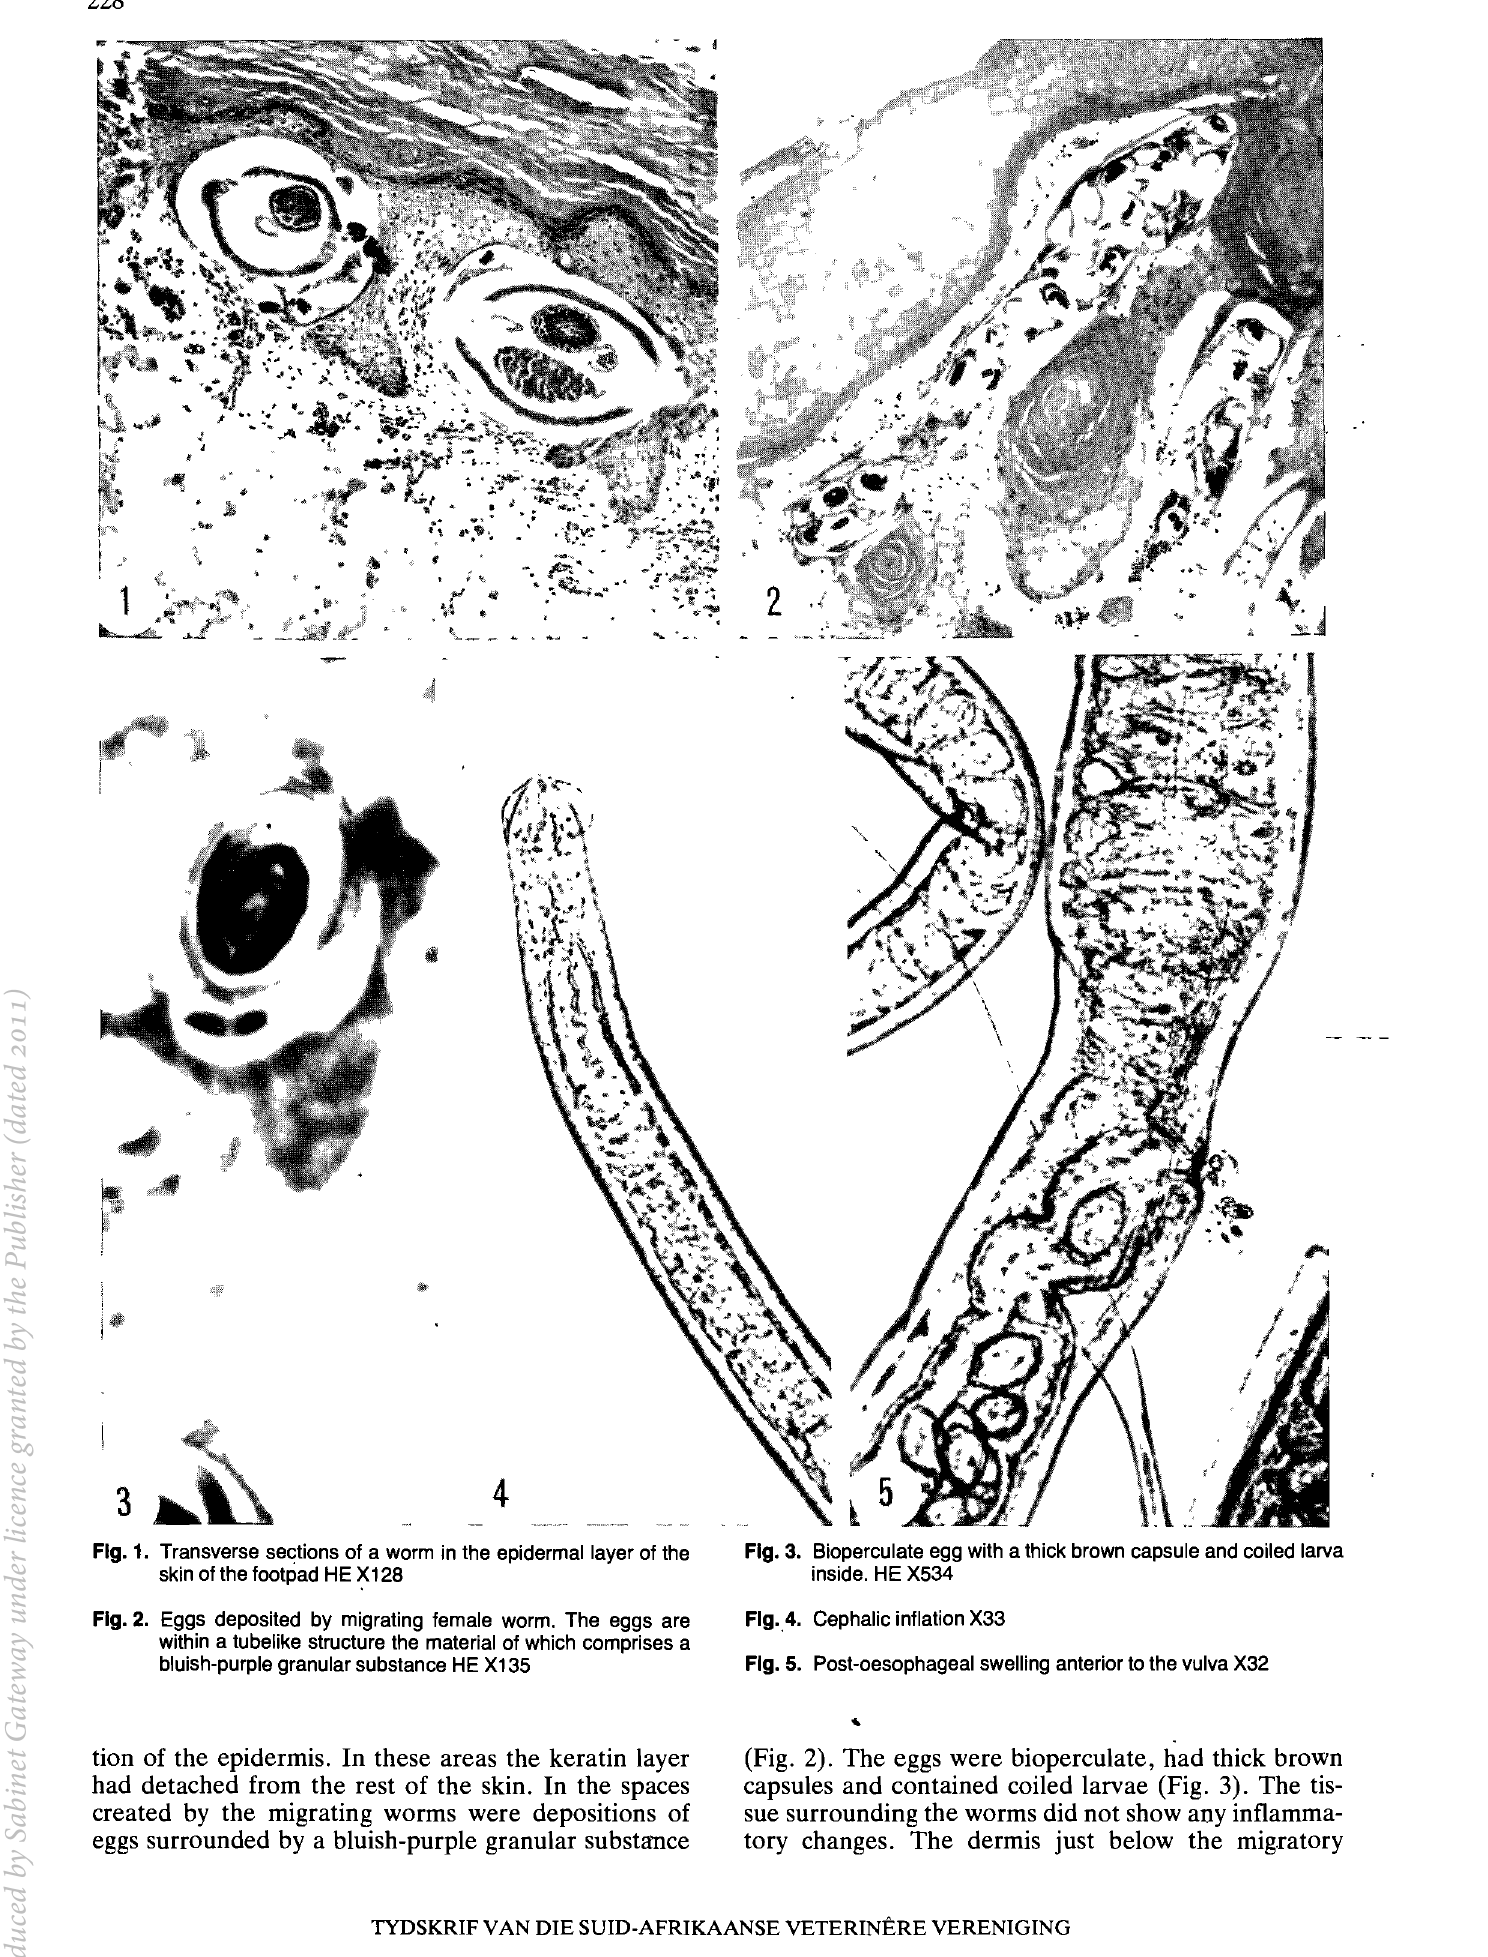
(Fig. 2). The eggs were bioperculate, had thick brown capsules and contained coiled larvae (Fig. 3). The tis sue surrounding the worms did not show any inflamma tory changes. The dermis just below the